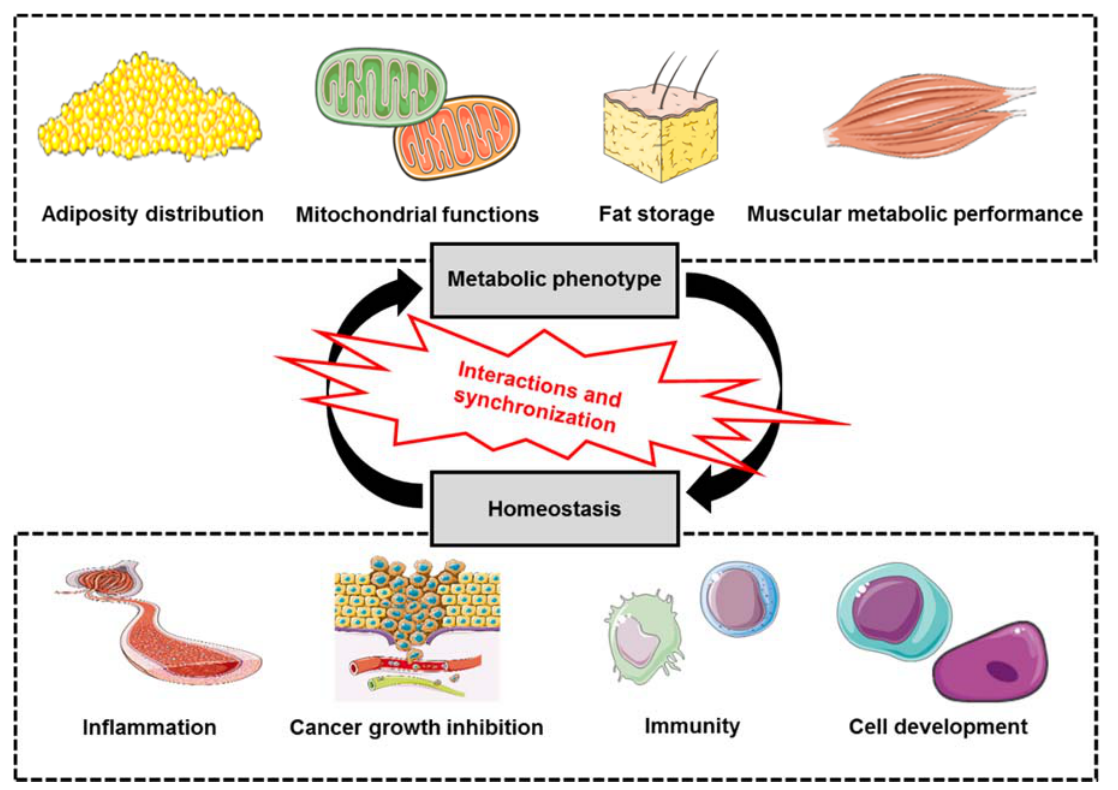
Figure 2. Secreted protein acidic and rich in cysteine (SPARC) metabolic and homeostatic implications. SPARC is involved in a variety of metabolic as well as homeostatic processes in diverse tissues, which suggest that SPARC simultaneously interacts with metabolism and homeostasis in order to synchronize with both of them.